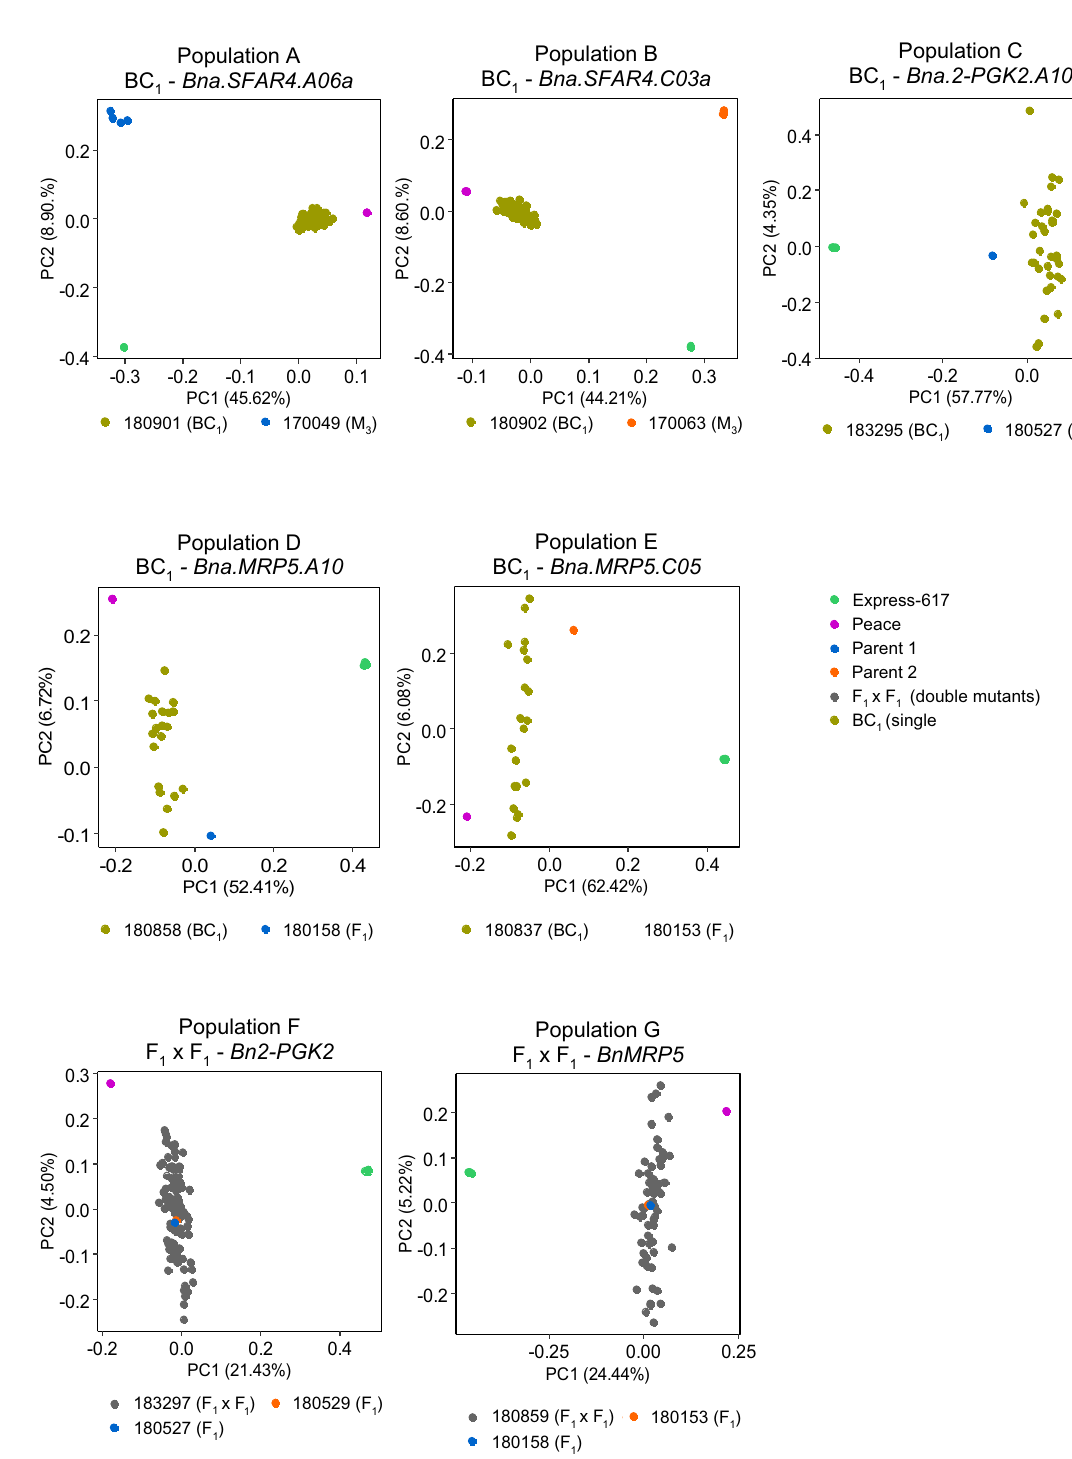
Figure 1. Principal component (PC) analysis with five BC 1 single mutant and two F 1 × F 1 double mutant oilseed rape populations. PCA was performed for each population separately, and PC1 and PC2 were displayed using the ggplot2 package in R. Seed codes of populations and respective parents are given at the bottom of each plot. Size of each population as follows, population A = 85, population B = 99, population C = 33, population D = 20, population E = 20, population F = 94, and population G = 60. M 3 mutants were used as the parents for populations A and B, while F 1 (M 3 × Peace) hybrids were taken as parental controls for populations C to